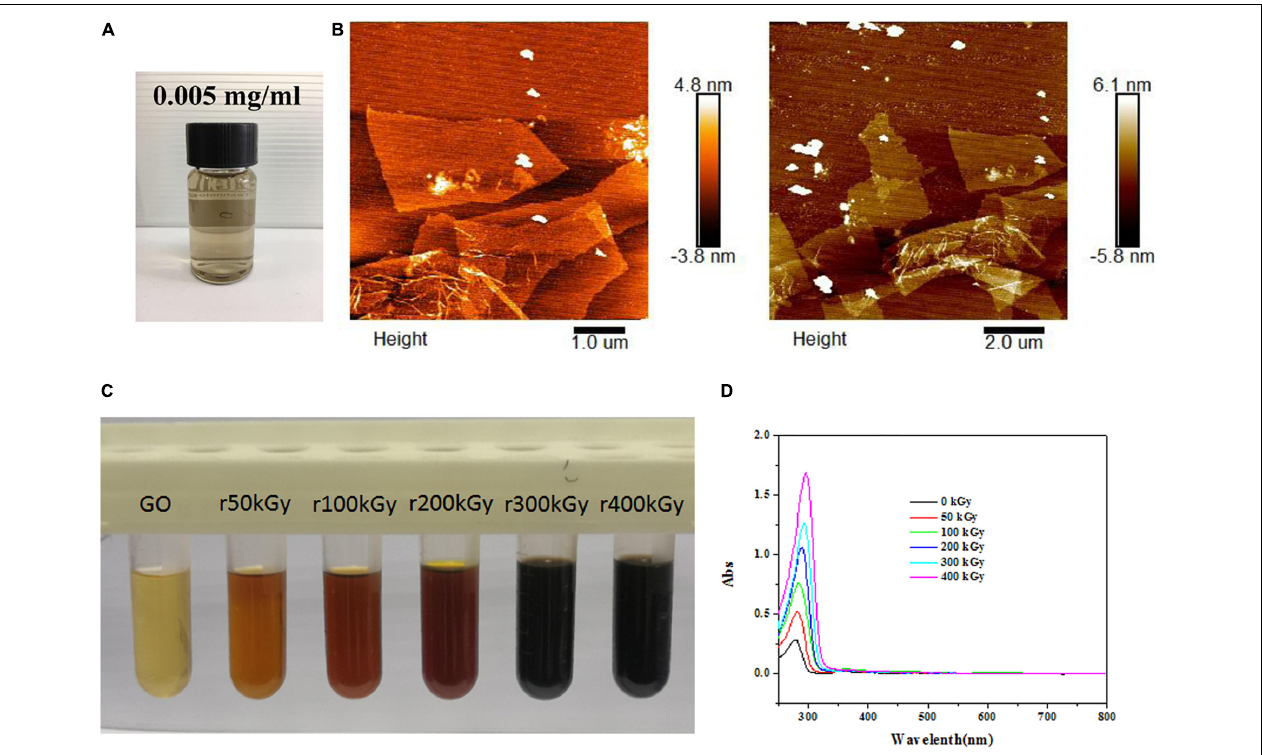
FIGURE 1 | Characterization of graphene oxide (GO) and reduced GO (rGO). (A) The appearance of commercial GO dispersion liquid. (B) The representative images of GO using atomic force microscopy. (C) The colors of GO exposed to different radiation absorbed doses. (D) The ultraviolet visible absorption spectra of GO exposed to different radiation absorbed